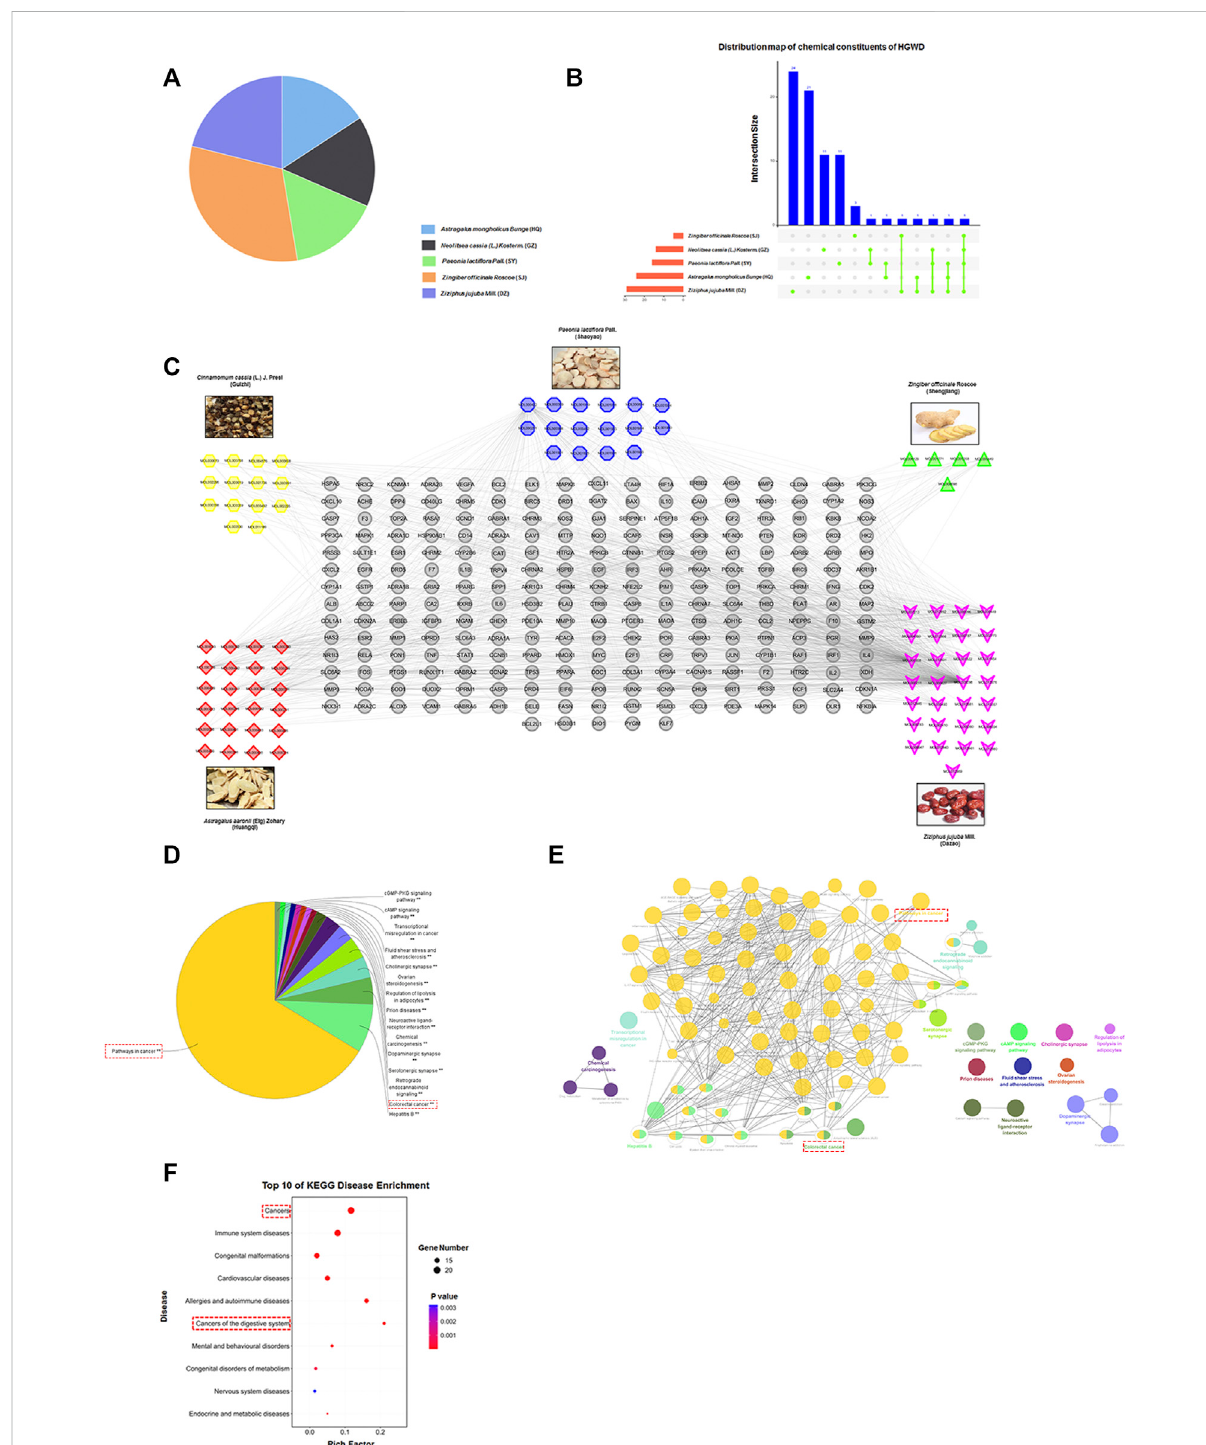
FIGURE 1 Establishment of HGWD candidate ingredient-target systematic network and enrichment analyses. (A) The quality matching of fi ve ingredients from HGWD (HQ, SY, GZ, SJ and DZ). (B) The distribution map of chemical constituents of HGWD. (C) The systematic network was established by linkingpotentialactiveingredientsandtheirputativedrugtargetsinHGWD. (D – F) Putativedrugtargetswererespectivelyenrichedinpathwayaswell as disease using ClueGO and KOBAS 3.0, ( p <